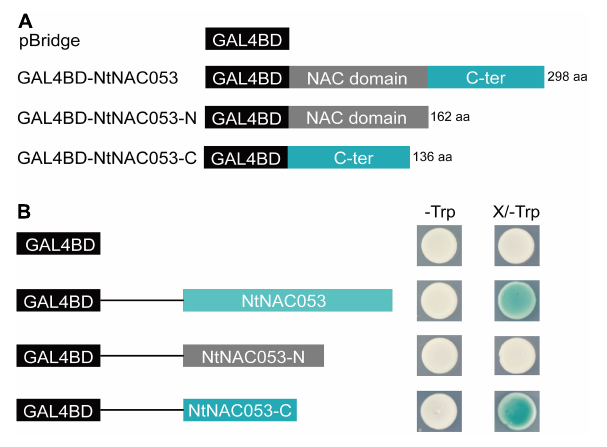
FIGURE 3 | The analysis of transcriptional activation activity of NtNAC053. (A) The fusion proteins with the GAL4 DNA-binding domain. (B) Transcriptional activation activity assay of NtNAC053 in the yeast strain AH109. The β -galactosidase activity was detected on the SD/-Trp/X-gal medium. NtNAC053-N represented the N-terminal region of NtNAC053 (1-162 aa); NtNAC053-C represented the C-terminal region of NtNAC053 (163-298